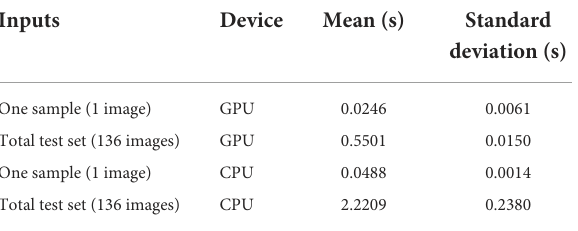
TABLE 1 Clock time consumption of the DL model.